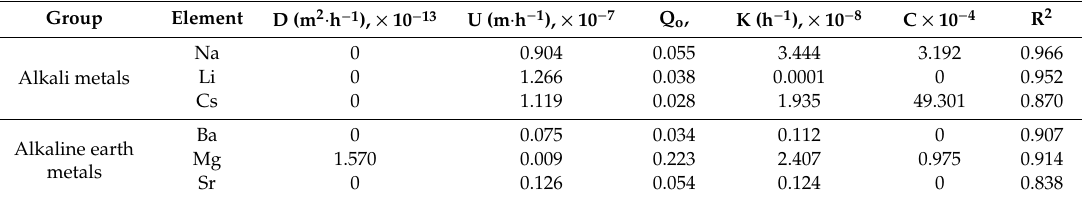
Table 12. Nonlinear curve fitting parameters of the cumulative leach fraction of alkali and alkaline earth metals: ABS-Waste (17).